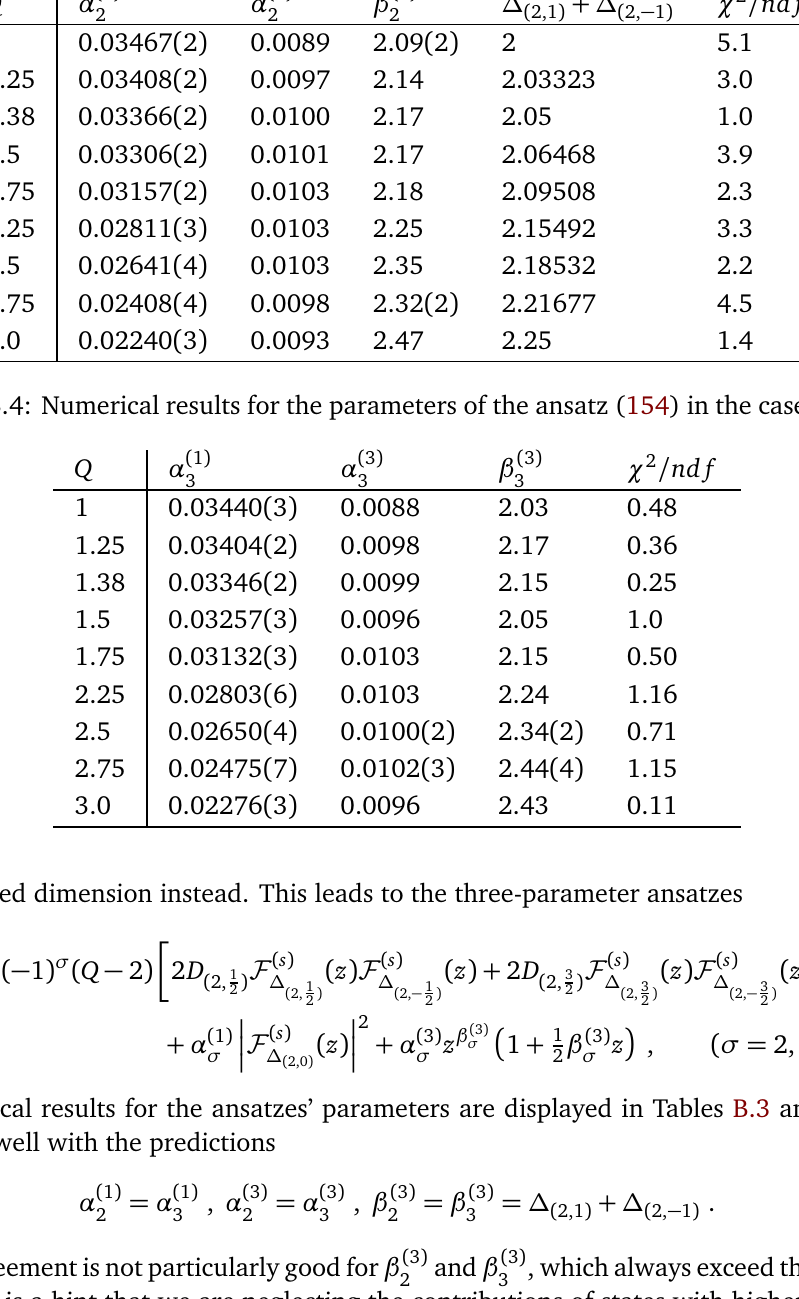
Table B.3: Numerical results for the parameters of the ansatz (154) in the case of P